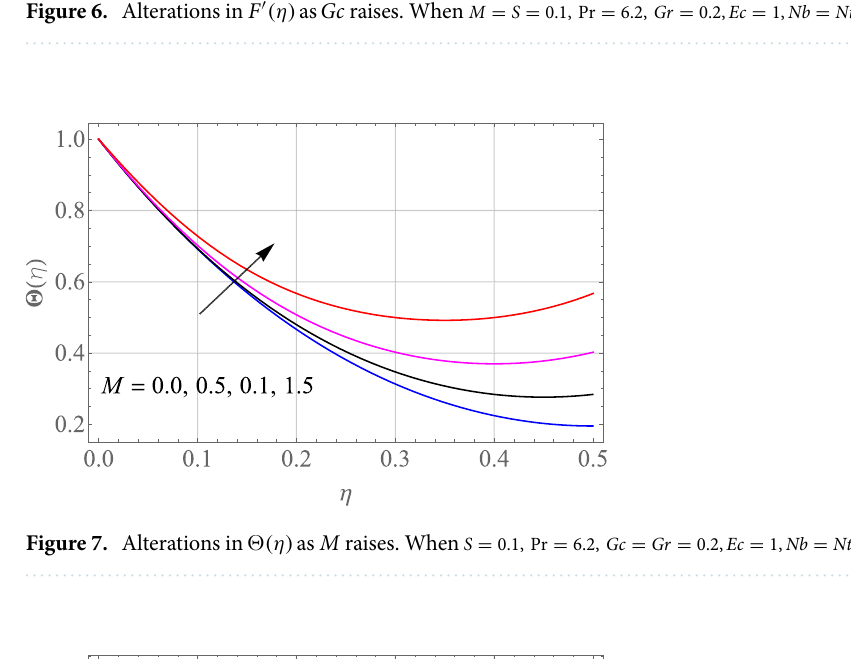
Figure 6. Alterations in F ′ (η) as Gc raises. When M = S = 0.1, Pr = 6.2, Gr = 0.2, Ec = 1, Nb = Nt = 0.3, Sc = 0.3 .